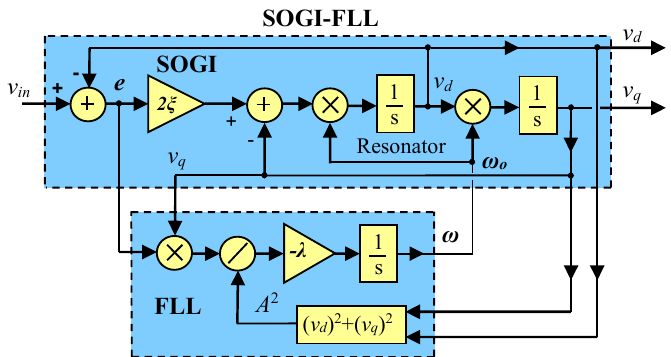
Figure 1. Block diagram structure of the Second-Order Generalized Integrator–Frequency-Locked Loop (SOGI-FLL) filter.